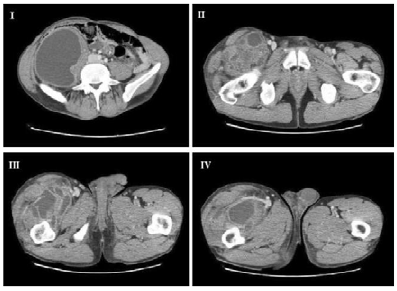
Figure 1. Preoperative basal computed tomography. The involvement of the psoas muscle and retroperitoneum from the Morrison’s pouch up to the right iliac fossa and to the iliac region is evident (I, II). The same CT scan shows the involvement of the right thigh with the cysts localized deeply and behind the muscular aponeurotic plane of the femoral quadriceps and abductor muscles up to the knee (III, IV).